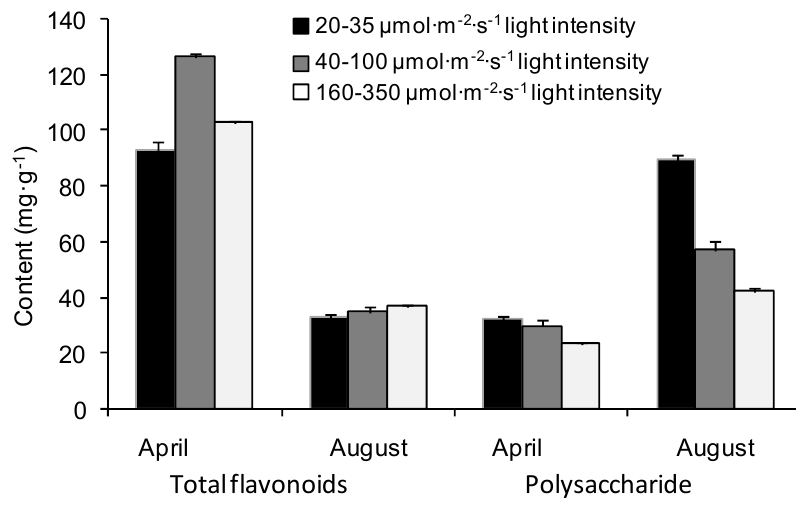
Figure 1. Contents of total flavonoids and polysaccharide influenced by different light intensities in light-controlled indoor cultivation. Bars are standard errors.